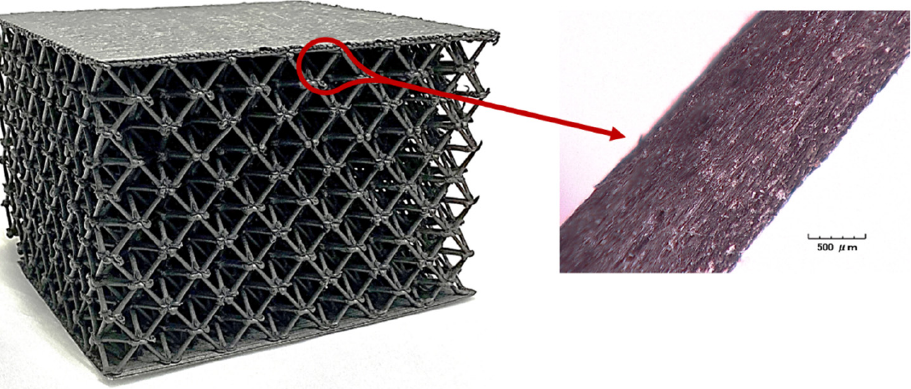
Figure 14. Close-up view of smooth continuous diagonal strut with axially aligned carbon fibers.